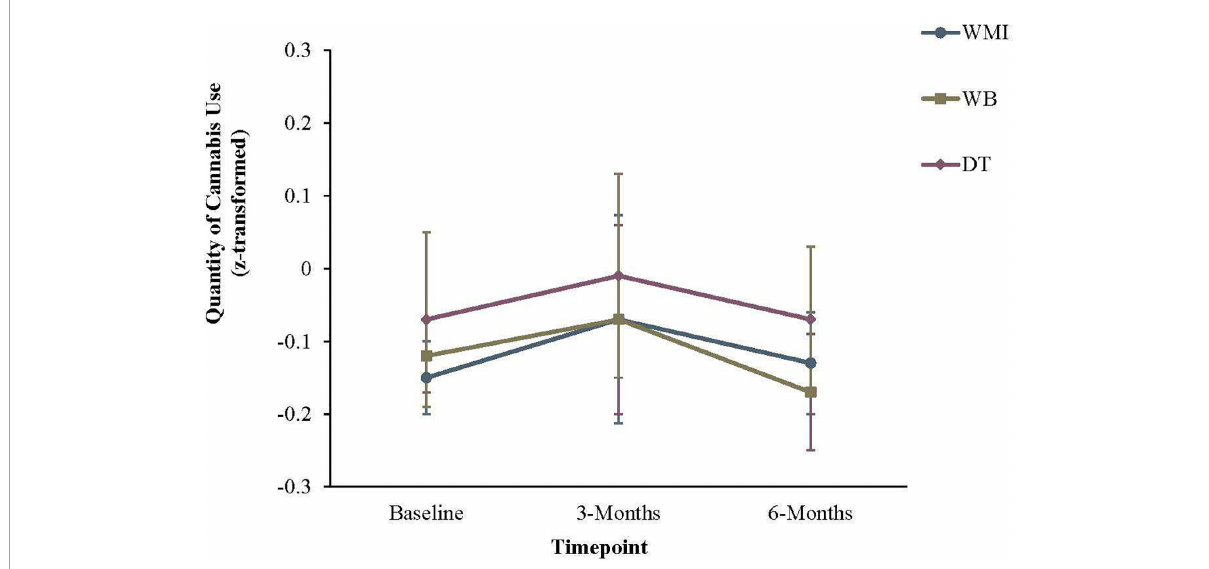
FIGURE3 Quantity of cannabis use in the previous 30 days. Error bars represent the 95% confidence interval for that group at a given timepoint. WMI, workbook plus motivational interview group; WB, workbook only group; DT, delayed workbook treatment